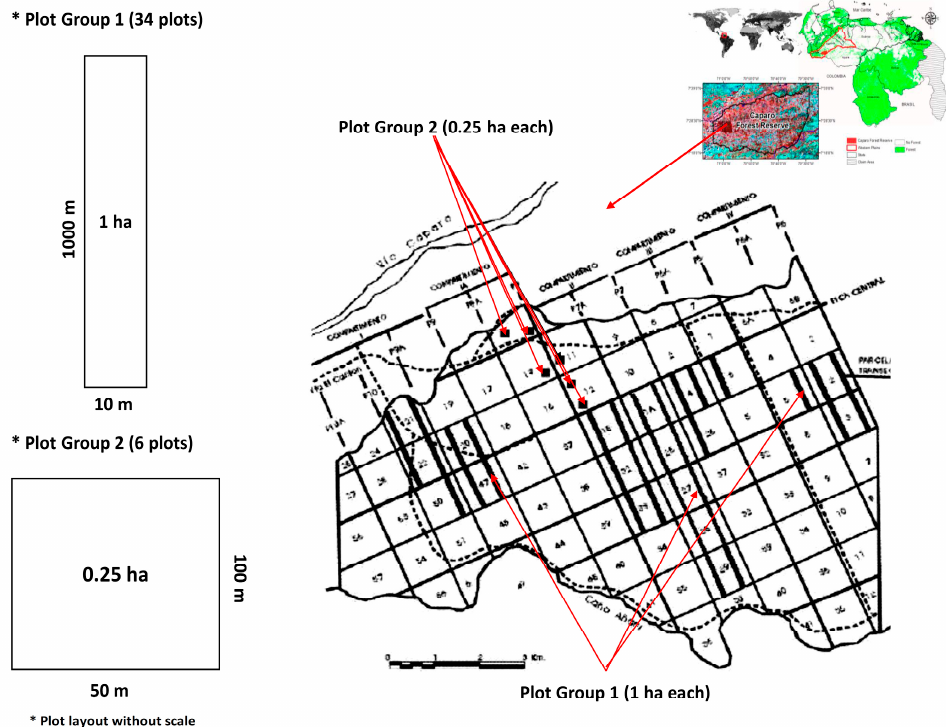
Figure A3. Location of permanent sample plots and general plot layout.